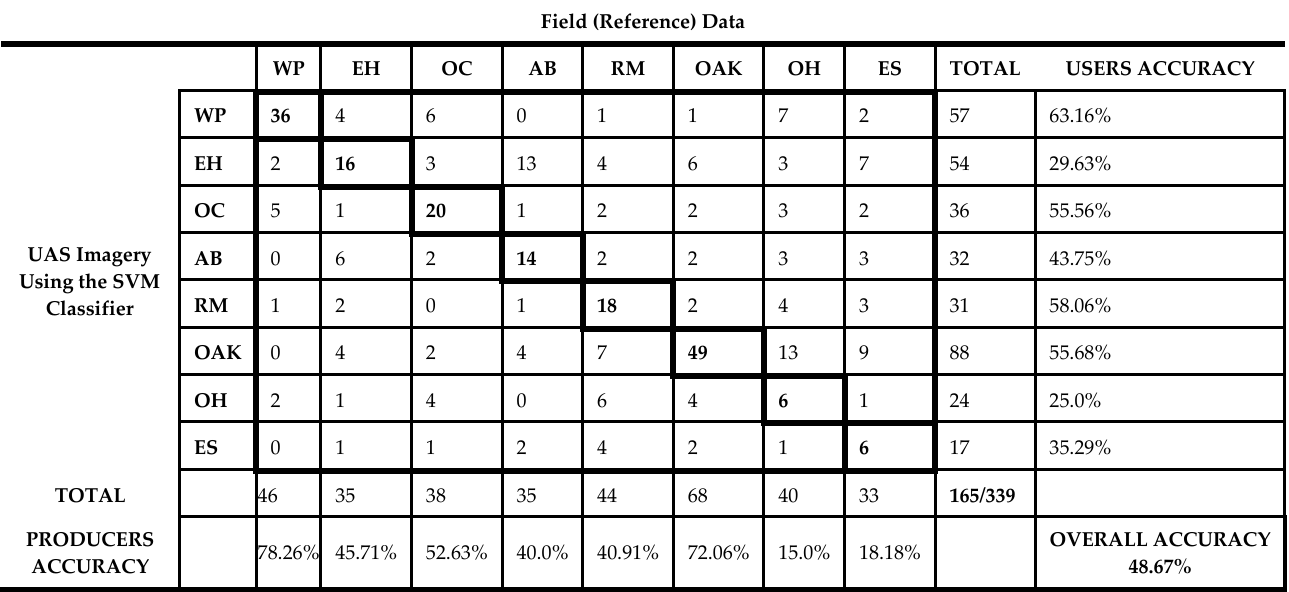
Table 8. Thematic map accuracy assessment error matrix for individual trees using the UAS imagery and the SVM algorithm for eight classes.